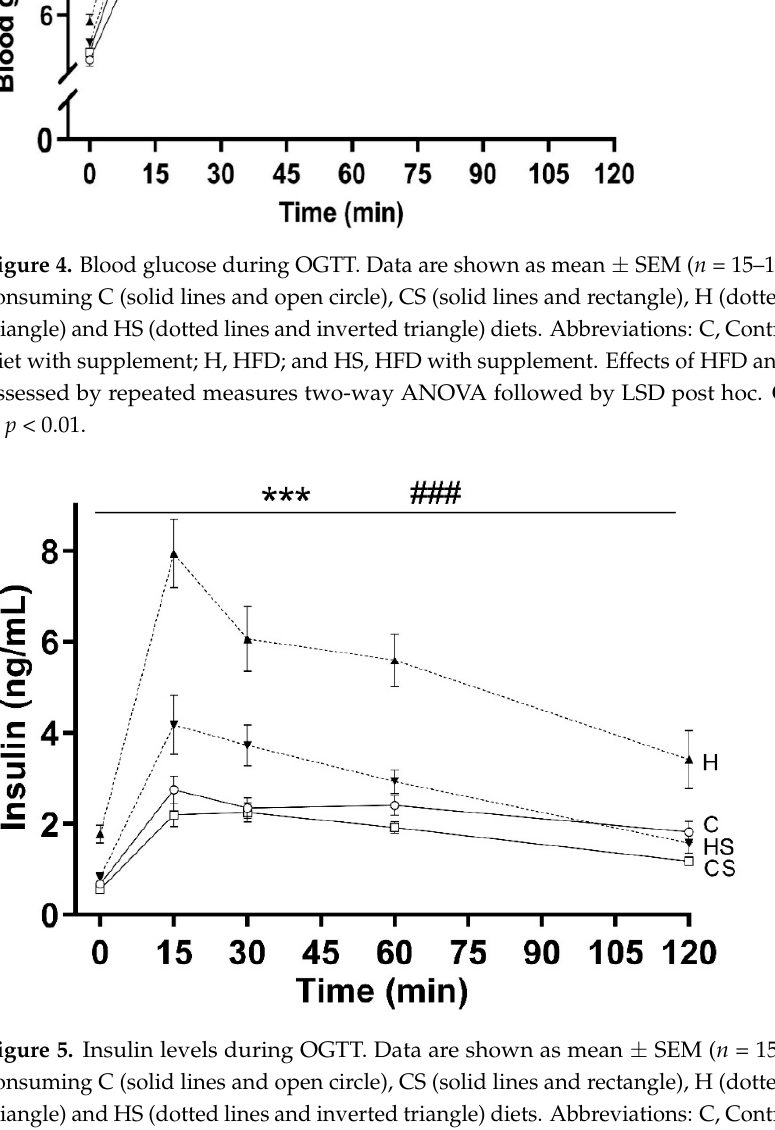
Figure 4. Blood glucose during OGTT. Data are shown as mean ± SEM ( n = 15–16 per group) in rats consuming C (solid lines and open circle), CS (solid lines and rectangle), H (dotted lines and upright triangle) and HS (dotted lines and inverted triangle) diets. Abbreviations: C, Control diet; CS, Control diet with supplement; H, HFD; and HS, HFD with supplement. Effects of HFD and supplement were assessed by repeated measures two-way ANOVA followed by LSD post hoc.